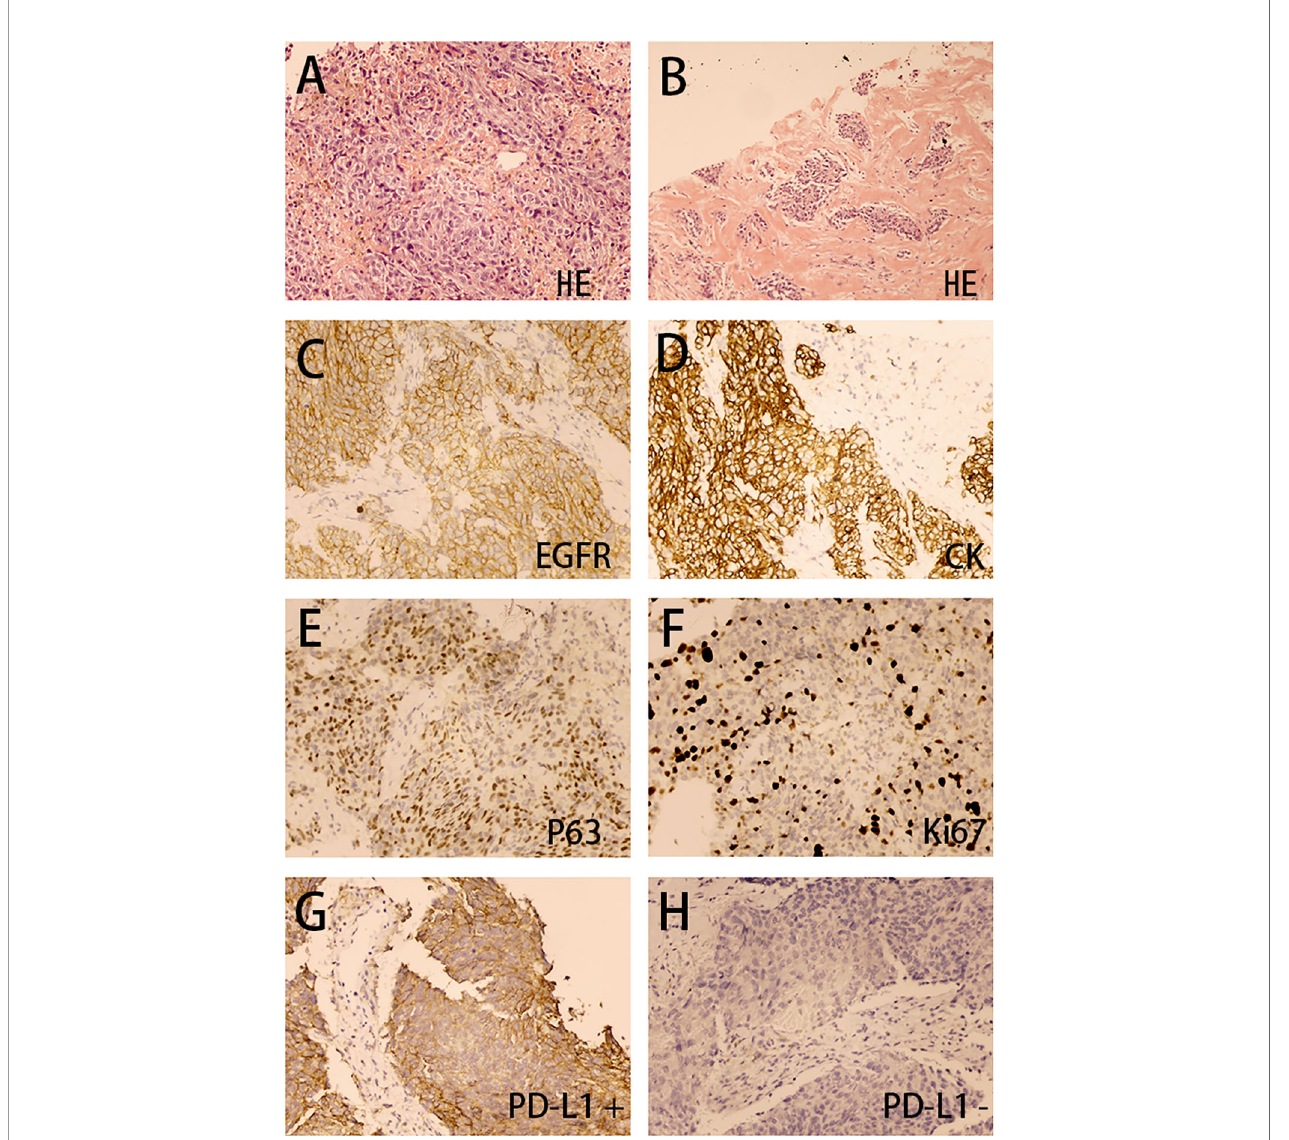
FIGURE 2 | Right paraventricular mass biopsy (200×). The H&E stain (A, B) showed poorly differentiated carcinoma in fi ltration in fi brous tissue. The immunohistochemical analysis (C – H) showed EGFR (+), CK (+), P63 (+), Ki67 (40%+), PD-L1 (CPS 80%+), and PD-L1 ( – ( Figure 2D ), P63 (+) ( Figure 2E ), and Ki67 (+40%) ( Figure 2F ), suggestingnonkeratinizingNPCmetastasis.Thestainingofthepatient ’ s tumor tissue with Roche SP142 revealed PD-L1 expression by the combined positive score (CPS) 80% staining positive ( Figures 2G, H ).